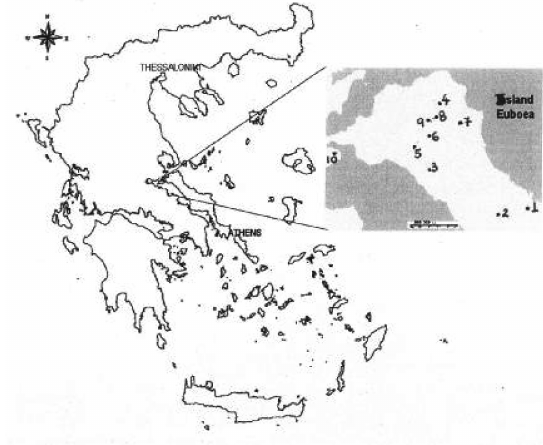
Figure 2. Geographical distribution of experimental plots in northern Evia, Greece.